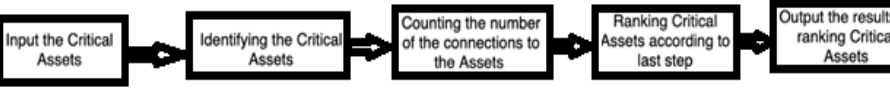
Figure 2. Workflow of our approach.